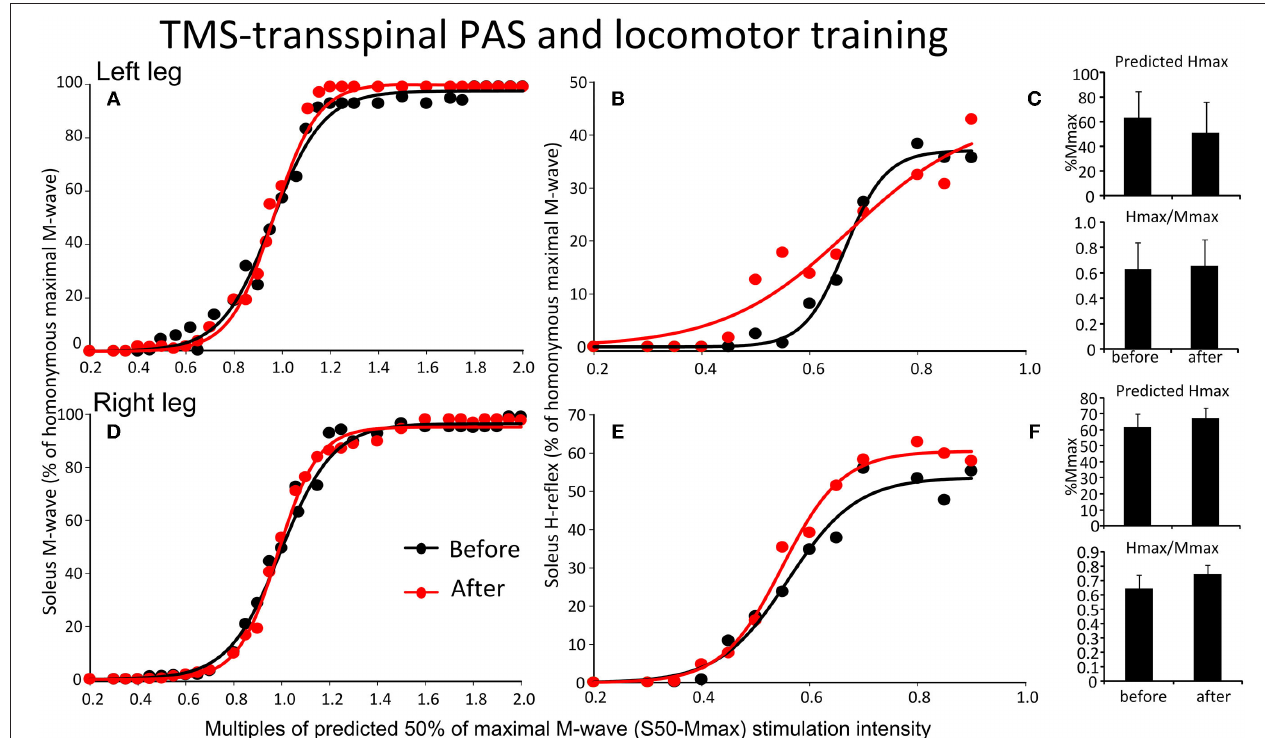
FIGURE 7 | Effects of TMS-transspinal PAS and locomotor training on soleus H-reflex input-output curves. Soleus M-waves and H-reflex recruitment input-output curves recorded at different stimulation intensities from the left (A,D) and right (B,E) legs during standing with body weight support before and after TMS-transspinal PAS and locomotor training. Sigmoid functions are fitted to the input-output curves. (C,F) Corresponding predicted Hmax and Hmax/Mmax for the left (C) and right (F) legs. Hmax, maximal H-reflex; Mmax, maximal M-wave; PAS, paired associative stimulation; TMS, transcranial magnetic stimulation. Error bars indicate the